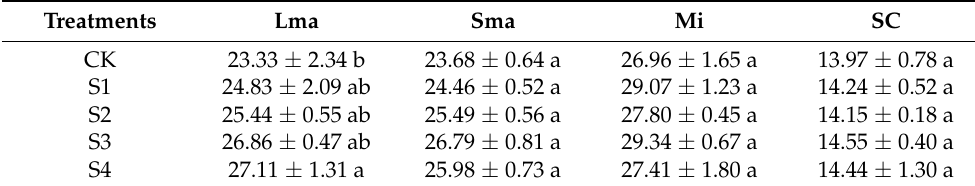
Figure 3. Effects of straw return on MWD, GMD, and WSA >0.25mm . MWD, mean weight diameter; GMD, geometric mean diameter; WSA >0.25mm , water-stable aggregates >0.25 mm. Different letters denote significant differences between treatments ( p < 0.05). CK, S1, S2, S3 and S4 represent rates of return of corn straw of 0, 6000, 9000, 12,000, and 15,000 kg hm − 2 , respectively.